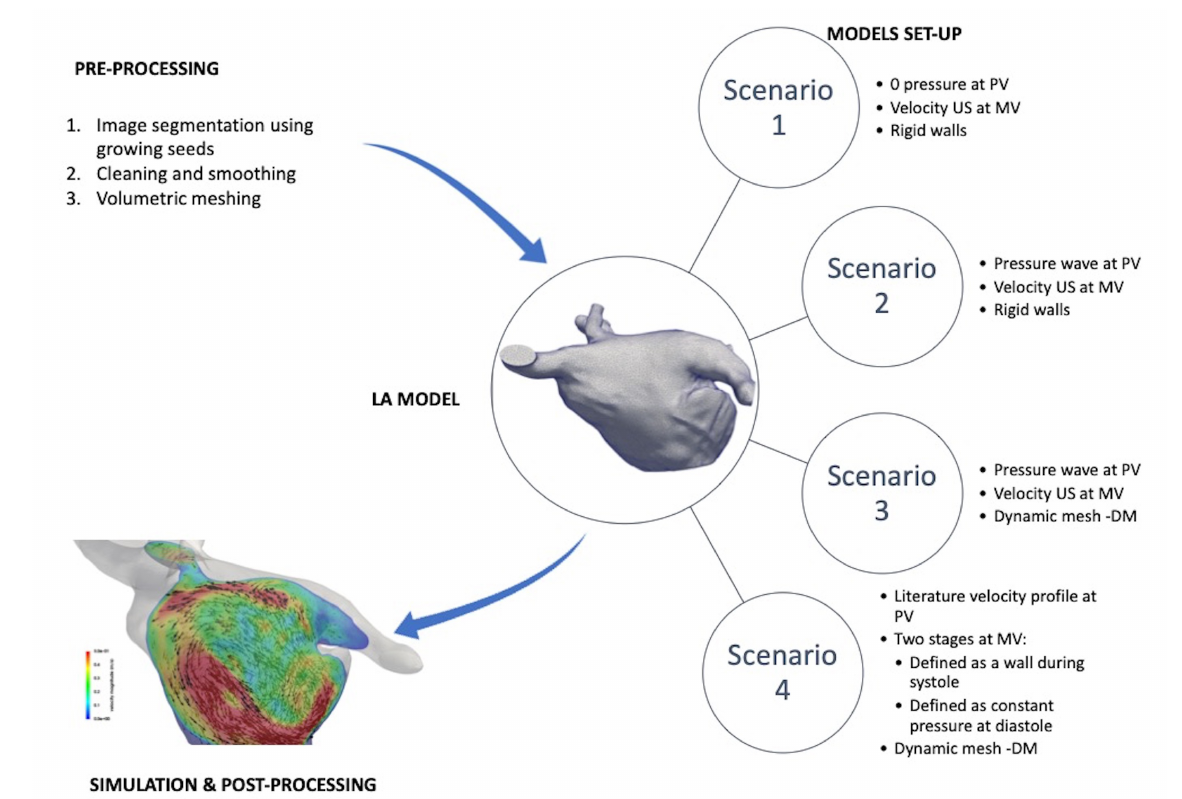
Figure 1. Fluid modelling pipeline, including preprocessing steps to build patient-specific left atria (LA) meshes and four different boundary conditions scenarios. PV: pulmonary veins; MV: mitral valve; US: ultrasound imaging; DM: dynamic mesh.